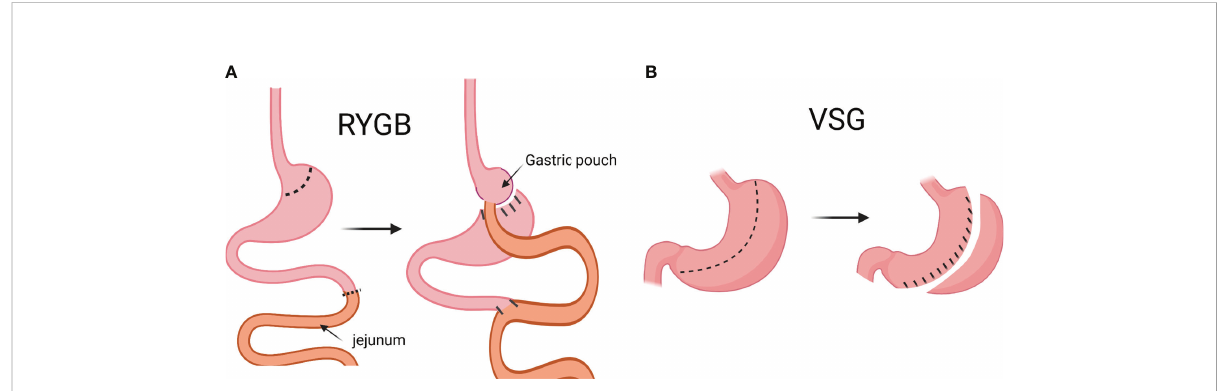
FIGURE 1 Graphical description of Roux-en-Y gastric bypass (RYGB) and vertical sleeve gastrectomy (VSG). In RYGB, the jejunum is cut, and the distal end is anastomosed to the small gastric pouch, and the proximal end is anastomosed to the rest of the jejunum (A) . In VSG, approximately 75-80% of the stomach is removed along the greater curvature to create a sleeve-like gastric pouch (B) . (Created with